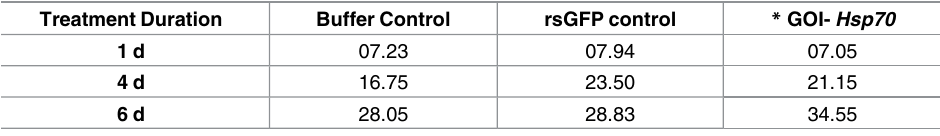
Table 6. Percent mortality for Hsp70 -dsRNA knockdown.